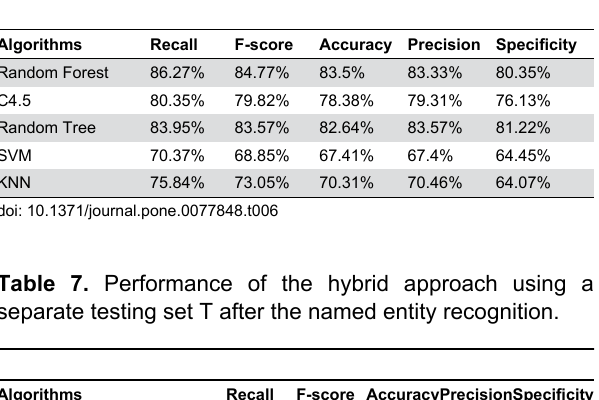
Table 6. 10-fold cross-validation accuracy of algorithms after applying them using the hybrid approach on entire set C after the named entity recognition.